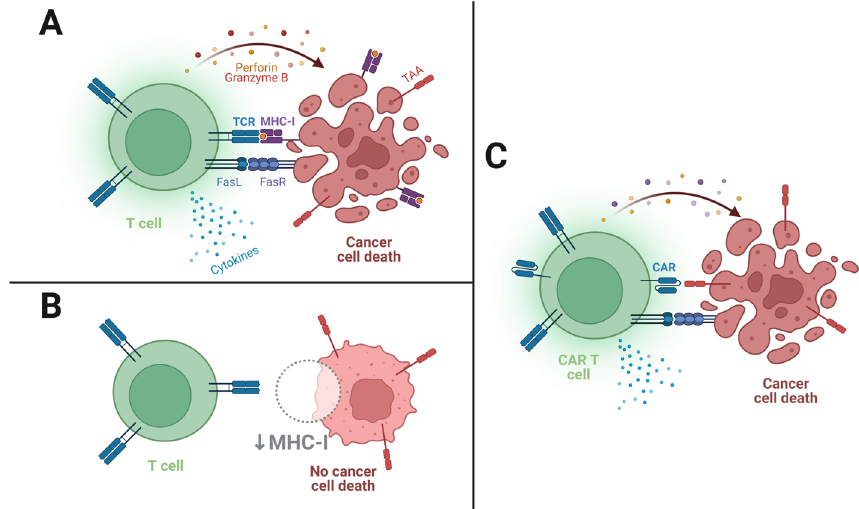
Figure 1. Schematics of T cell and CAR T cell killing mechanisms. ( A ) TCR recognition of a cancer cell’s TAA epitope presented on MHC-I induces killing of the target cell; ( B ) Downregulation of MHC-I by the cancer cell prevents T cell activation and subsequent target cell killing; ( C ) CAR recognition of the surface-expressed TAA triggers killing mechanisms despite MHC-I downregulation.